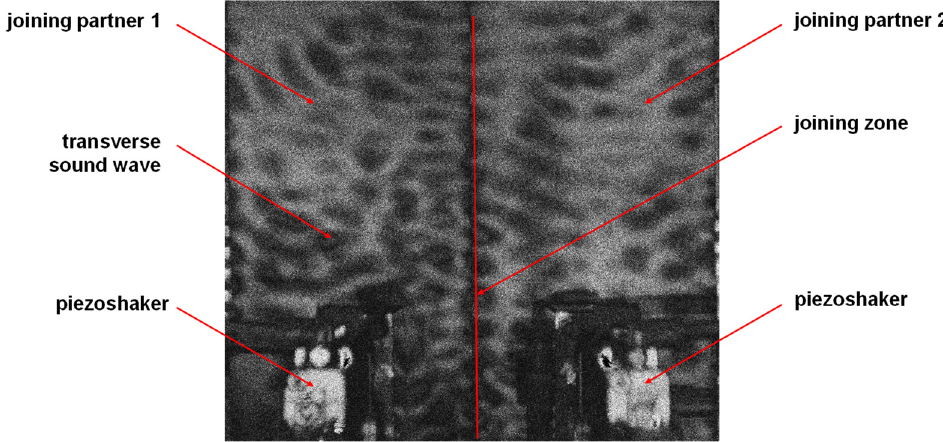
Figure 3. Vibration visualization by means of shearography.